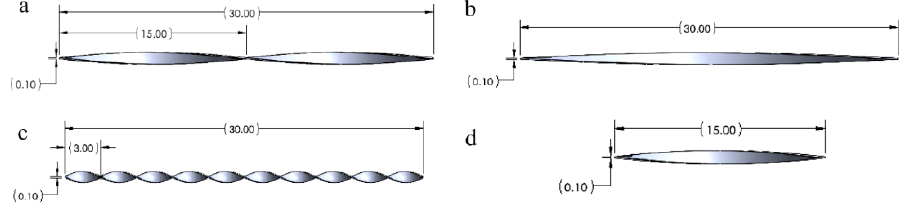
Figure 5. Twist ratio of ( a ) full-twist twisted tape; ( b ) half-twist twisted tape; ( c ) twist ratio 3 twisted tape; ( d ) half-length twisted tape.